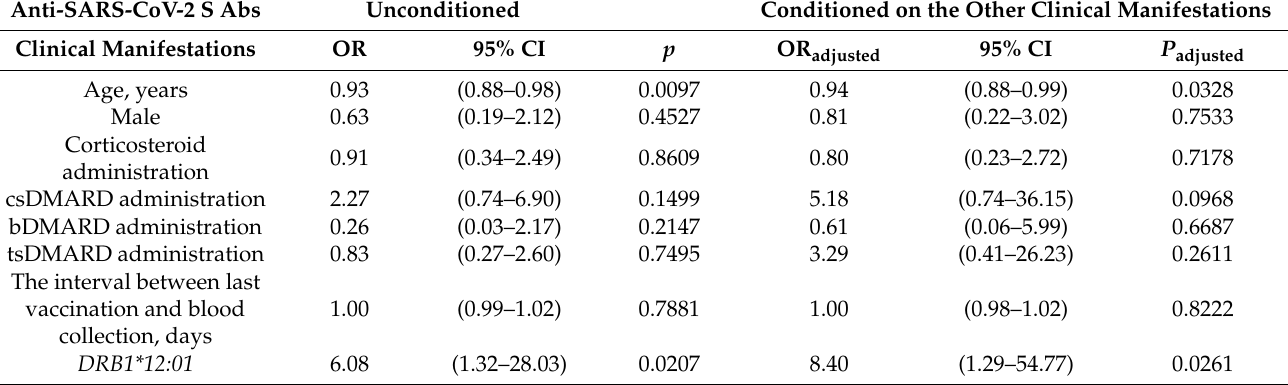
Table 6. Multiple logistic regression analysis of DRB1*12:01 and clinical manifestations: impact on anti-SARS-CoV-2 S Abs.